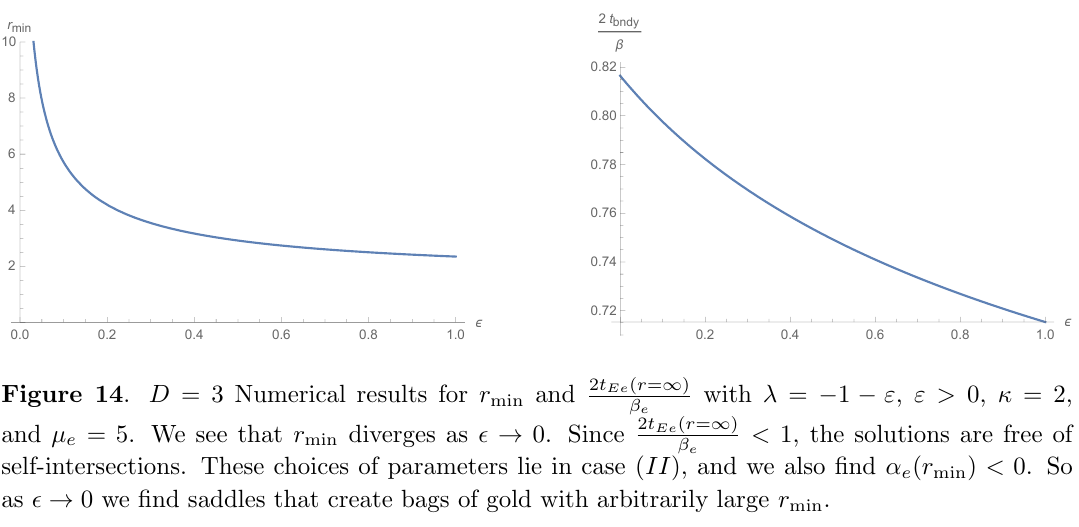
Figure 14 . D = 3 Numerical results for r min and 2 t Ee ( r = 1 ) and (cid:22) e = 5. We see that r min diverges as (cid:15) ! 0. Since 2 t Ee ( r = 1 )